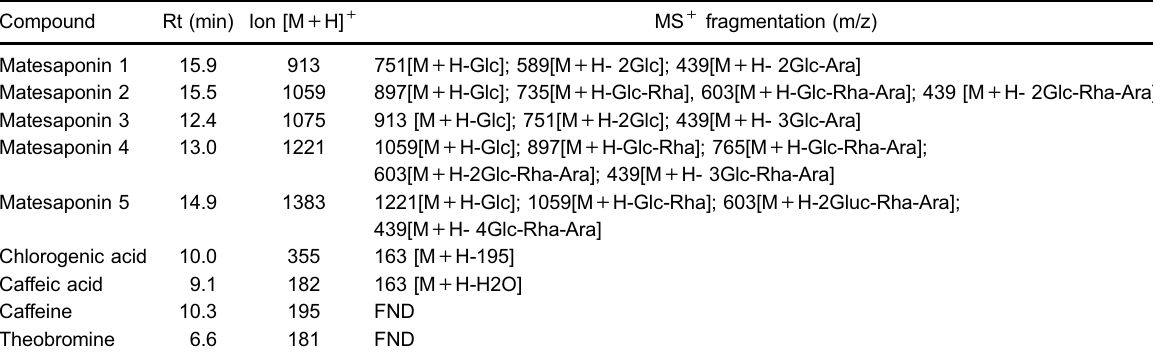
Table 1. Chemical components identi fi ed in yerba mate extract with corresponding retention times (Rt), quasi-molecular ions in the positive mode and key fragments LC-ESI-MS.